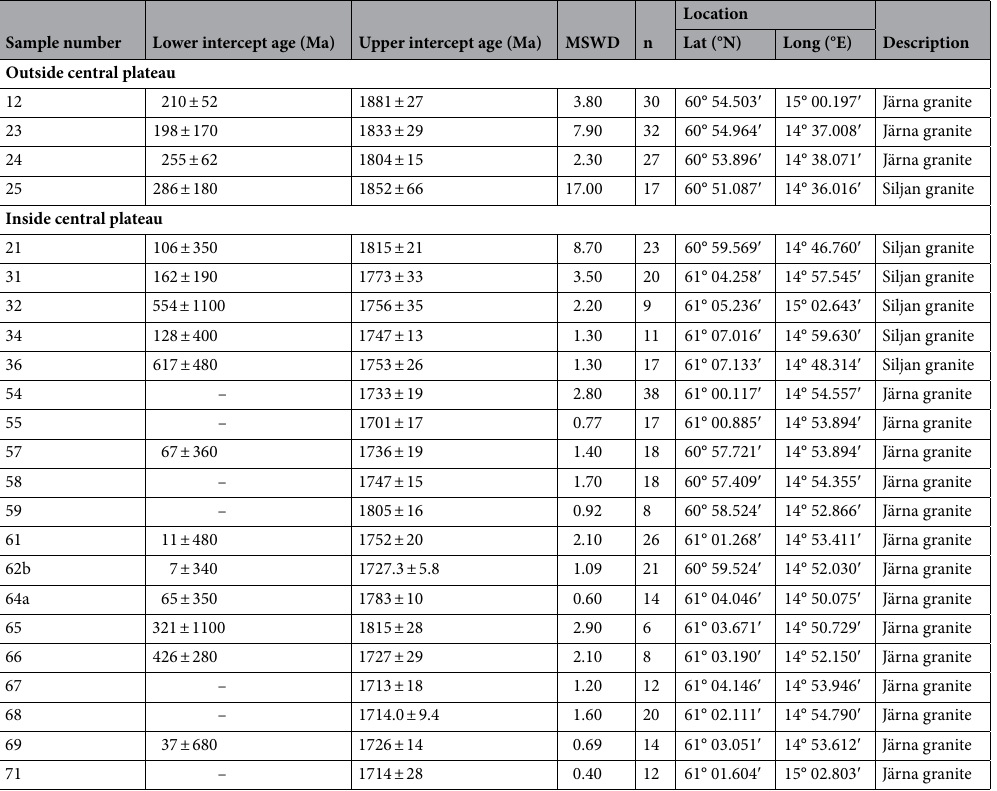
Table 1. Summary of the U–Pb data, including the upper and lower intercept dates, MSWD, n = number of analyses, coordinates of sample localities and granite